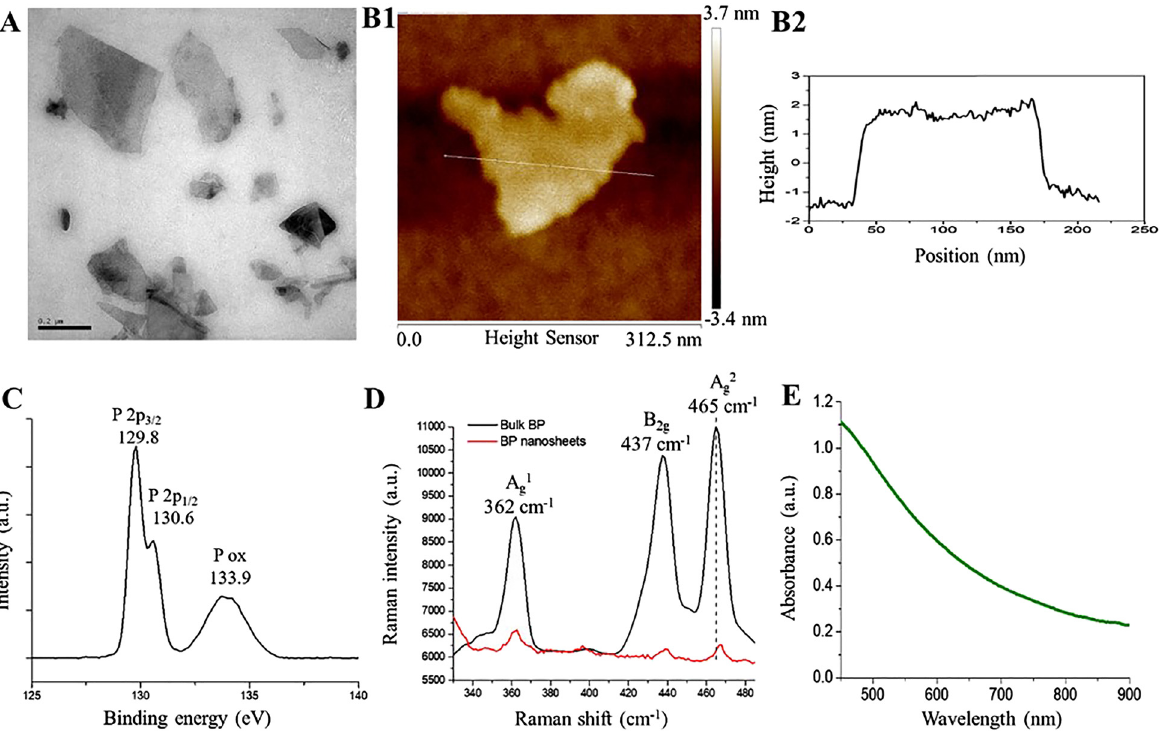
Figure 1: (A) – (C) The transmission electron microscope (TEM) image, atomic force microscope (AFM) image, and X-ray photoelectron spec- troscopy (XPS) spectrum of the exfoliated black phosphorus (BP) nanosheets, respectively. The scale bar in (a) is 0.2 μ m.(B2) The height pro fi le along the whiteline in (B1). (D) The Ramanspectra of bulkBPs andBPnanosheets. (E) The absorptionspectrum ofthe exfoliatedBP